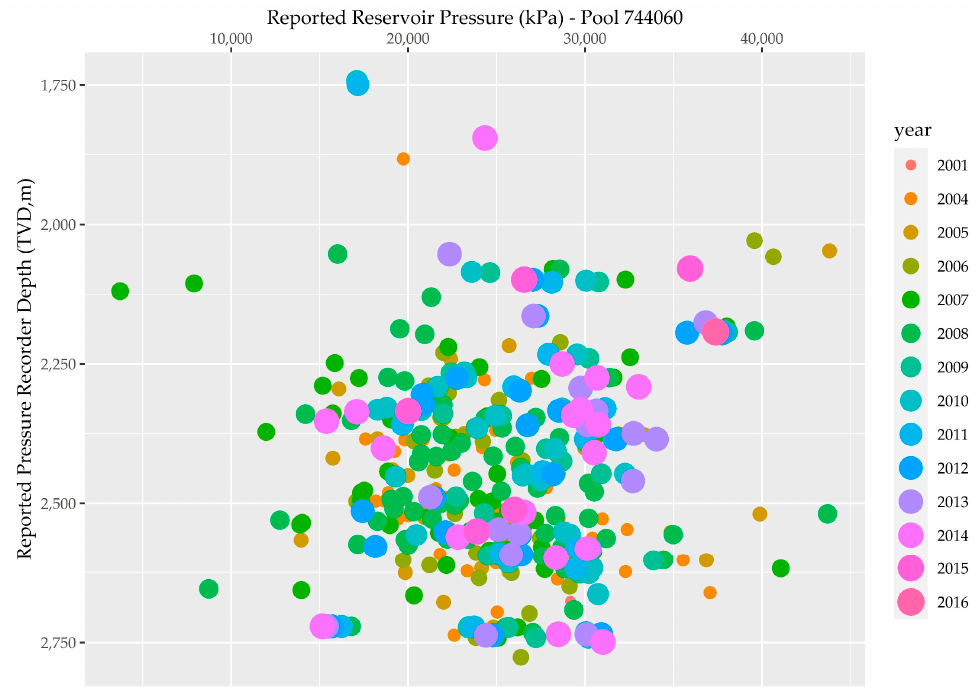
Figure 14. An example of data scatters in the pool pressure-survey records contained in the geoSCOUT TM database. Source data extracted from geoLOGIC Systems databases © 2020. Figure 14. Examples of data scatter in the pool pressure-survey records contained in the geoSCOUT database. Source data extracted from geoLOGIC Systems databases ©